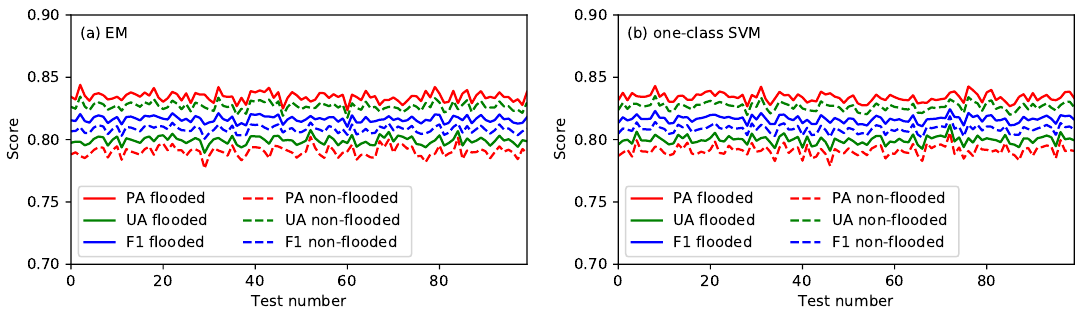
Figure 14. Producer accuracy (red lines), user accuracy (green lines), and F1 (blue lines) scores for flooded (solid lines) and non-flooded (dashed lines) agricultural targets. ( a ) Scores computed from the classification of the EM algorithm. ( b ) Scores computed from the classification of the one-class